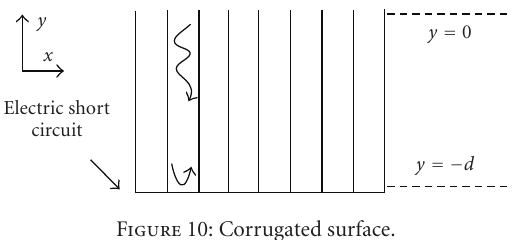
Figure 10: Corrugated surface.